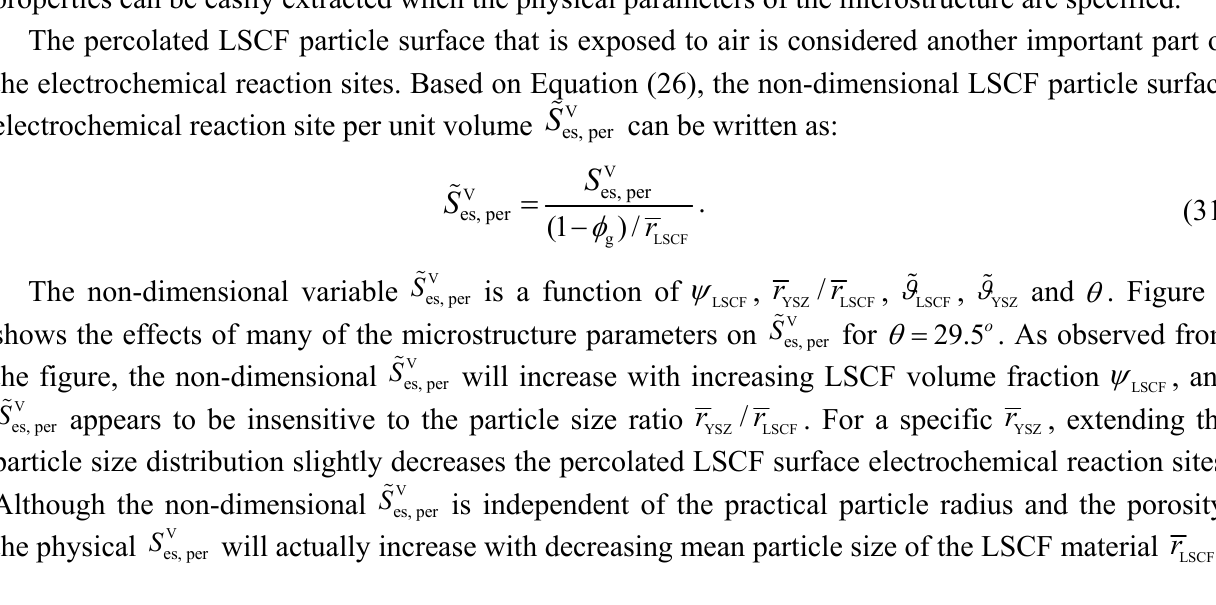
Figure 7. The non-dimensional LSCF particle surface electrochemical reaction site per unit